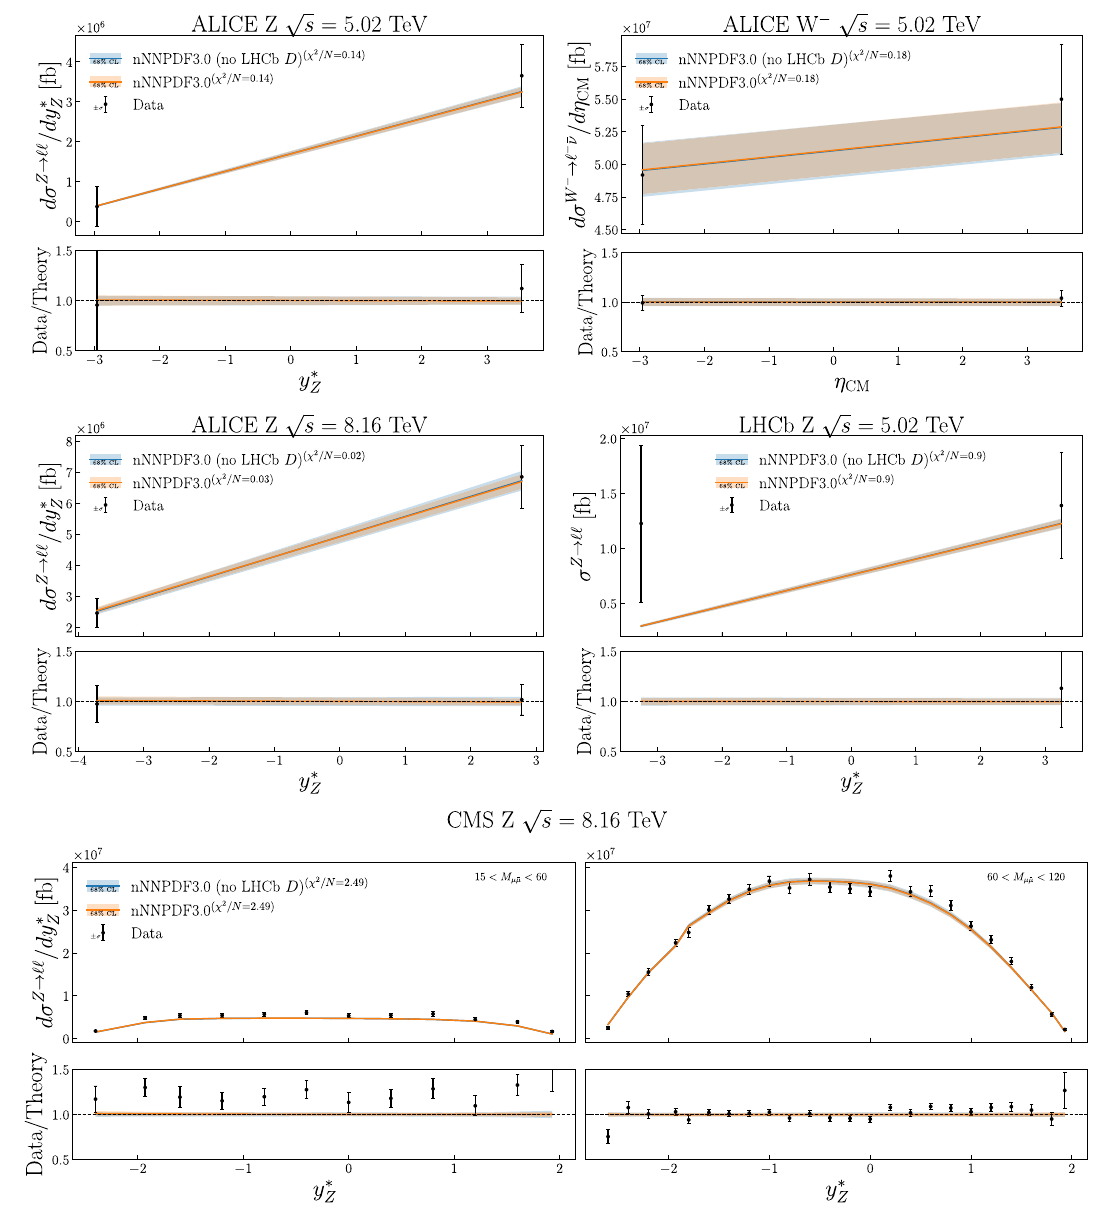
Fig. 33 Same as Fig. 31 for other LHC datasets on gauge boson pro- duction in pPb collisions, in particular the ALICE and LHCb forward and backward measurements of W and Z production at 5.02 TeV and